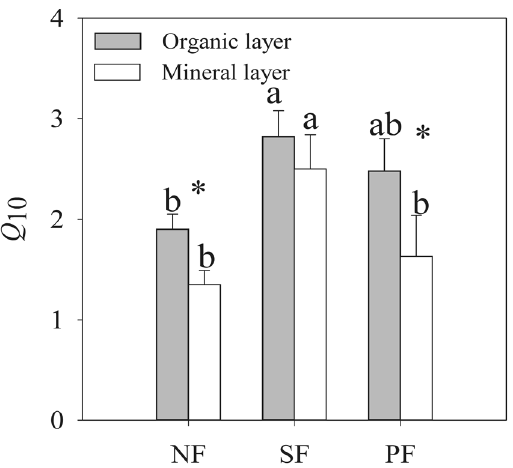
Figure 4. Effects of forest type conversion and soil layer on temperature coefficient Q 10 . Values indicate means ± SE, n = 4. Different letters within the same soil layer denote significant differences among forest types by one-way ANOVA. Asterisk indicates significant differences between the two soil layers by student t -test. NF: natural forest, SF: secondary forest and PF: spruce plantation.